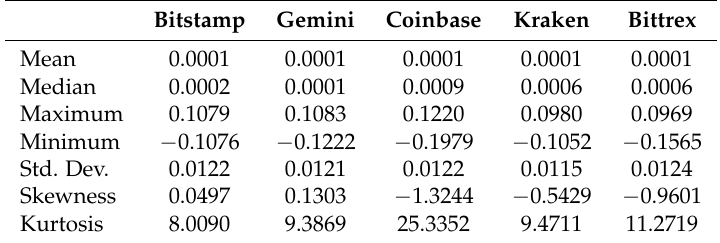
Table 3. Summary Statistics of Returns.